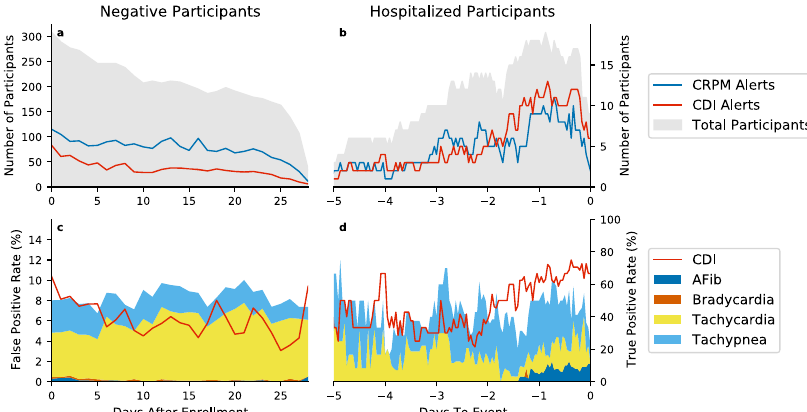
Fig. 4 Comparison of a continuous remote monitoring system with clinical alerting rules to CDI. a The daily count of non-hospitalized participants with any false alerts. b The hourly count of alerts generated for hospitalized participants in the 5 days before hospitalization. In both a , b the light gray background denotes the number of participants with data at each timepoint. c The daily false positive rate of CDI and the component alerts. d The hourly true positive rate of CDI and the component alerts fi ve days before